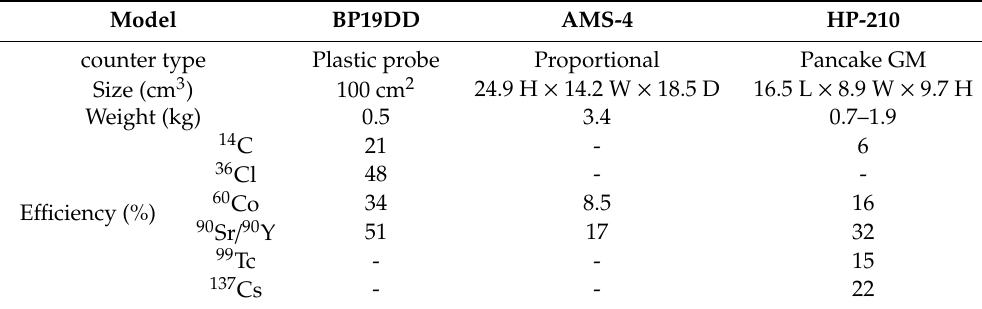
Table 18. ThermoFisher